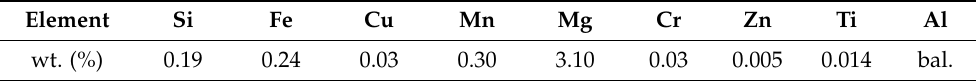
Table 1. Chemical composition of AA 5754-H111 aluminium alloy used [9]. Element